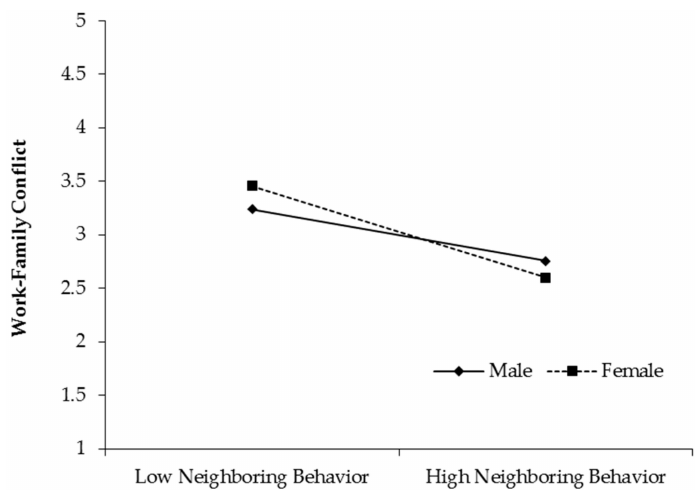
Figure 4. Moderating role of gender in the relationship between neighboring behavior and work-family